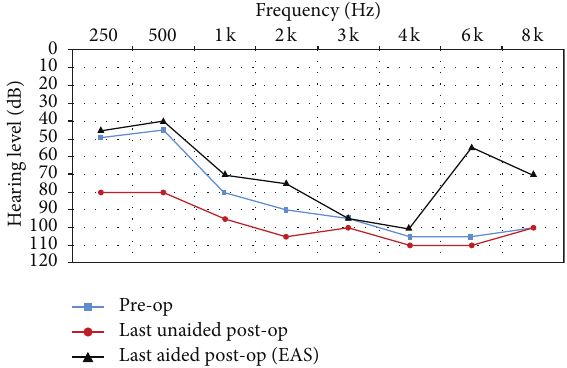
Figure 3: Audiometric results for Subject 3.